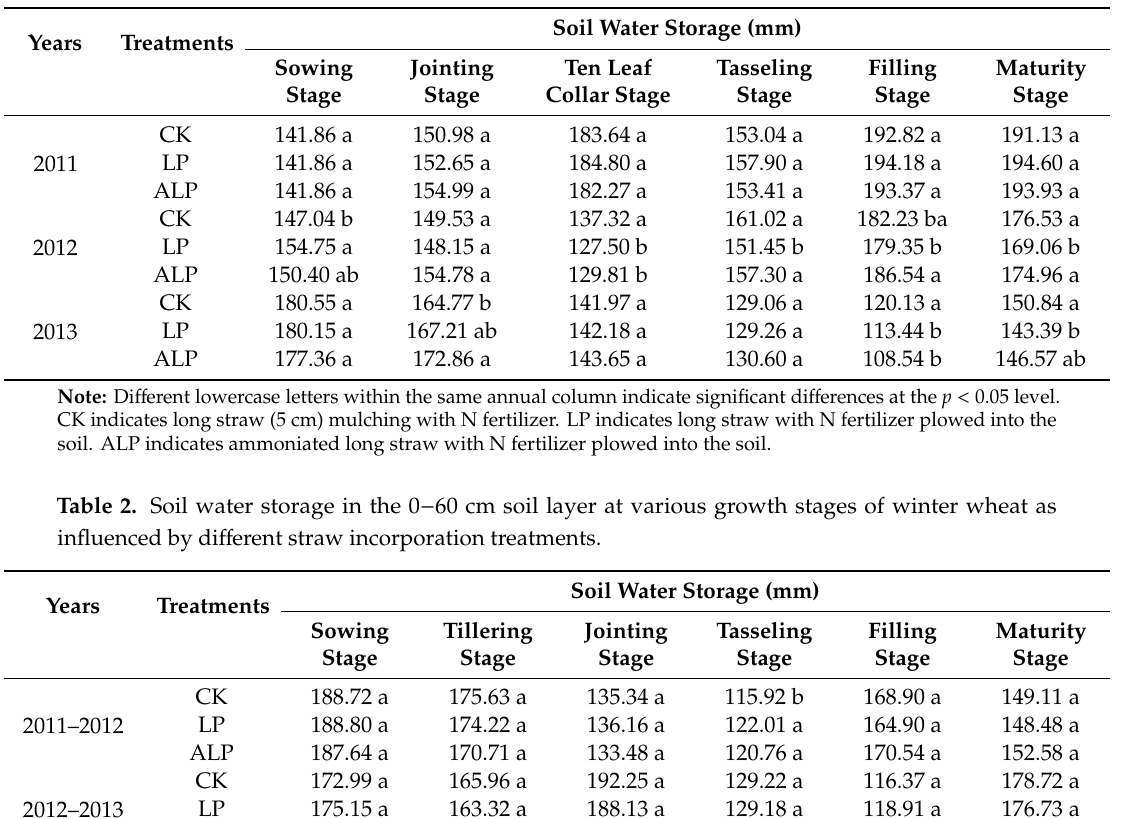
Table 1. Soil water storage in the 0 − 60 cm soil layer at various growth stages of summer maize as influenced by di ff erent straw incorporation treatments.